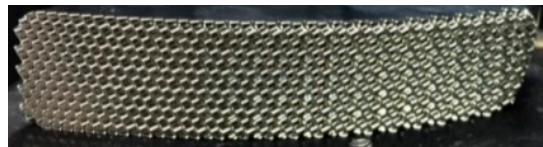
Figure 25. Prototyped CCCR of the optimized design.